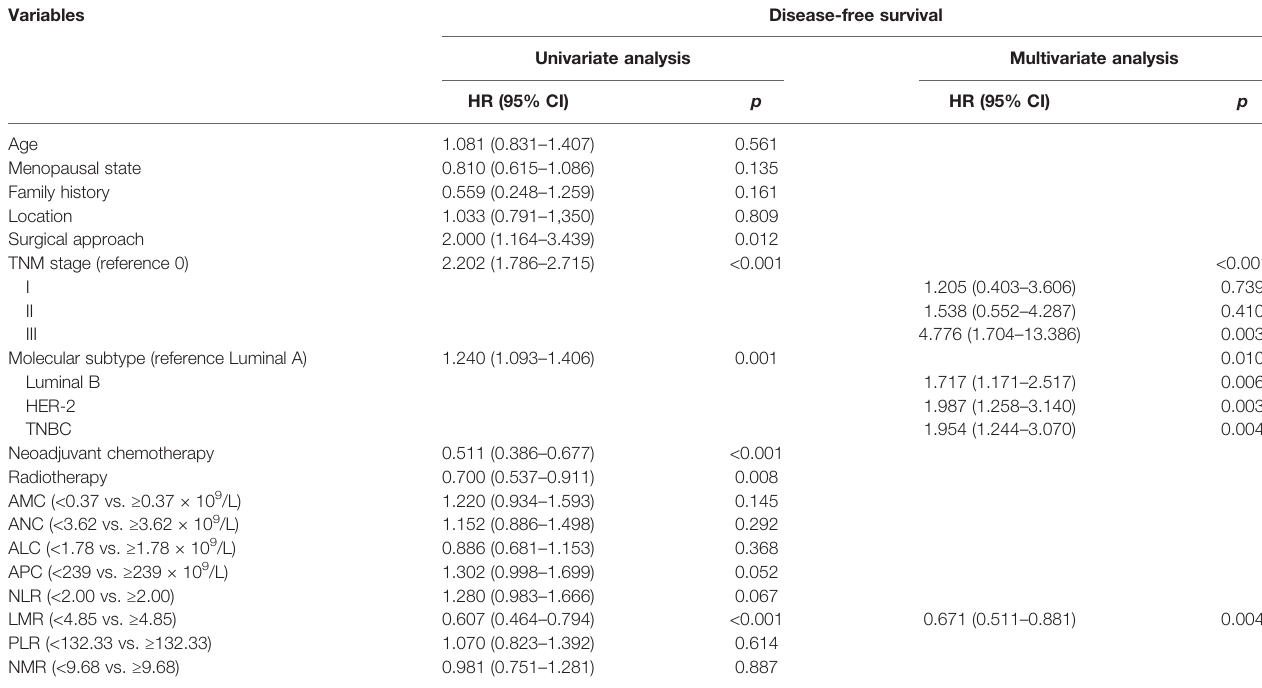
TABLE 2 | Univariate and multivariate Cox regression analyses of hematologic parameters and clinicopathological characteristics for survival in patients with breast cancer. Variables